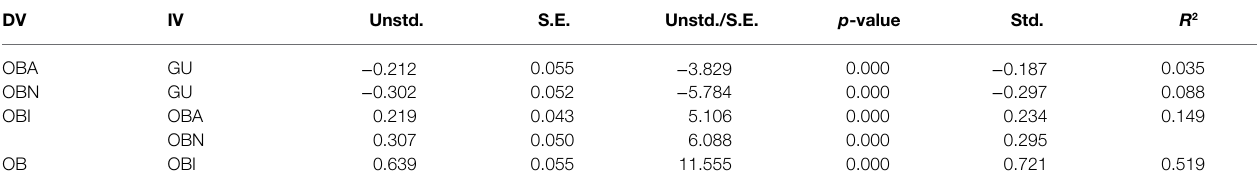
TABLE 7 | Regression coefficient.